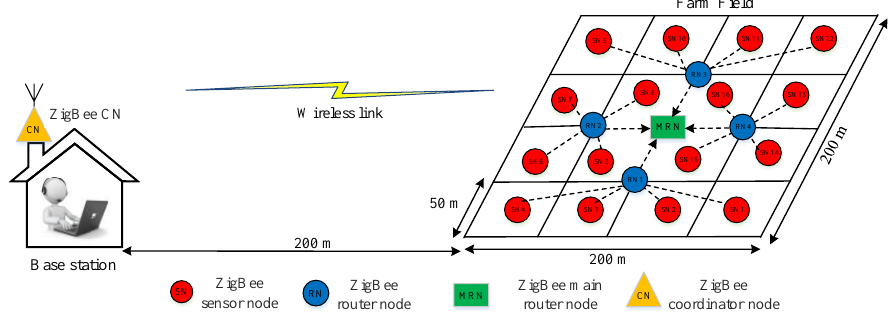
Figure 1. WSN topology of the proposed WAS for precision farming.